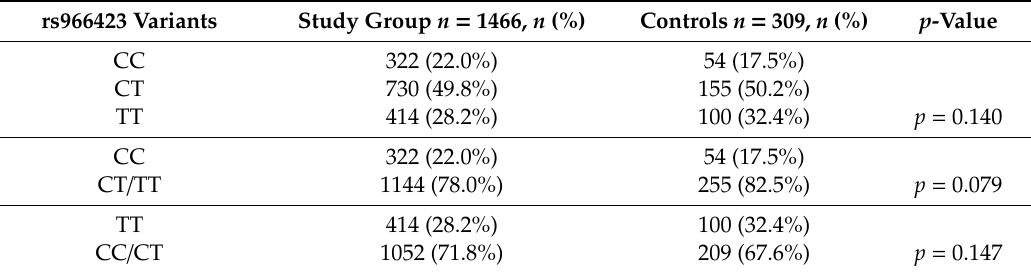
Table 3. Frequency of rs966423 variants among the study and control